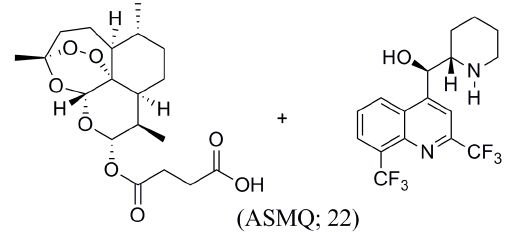
Figure 7 - Structure of drugs used in ASMQ combination 22 .